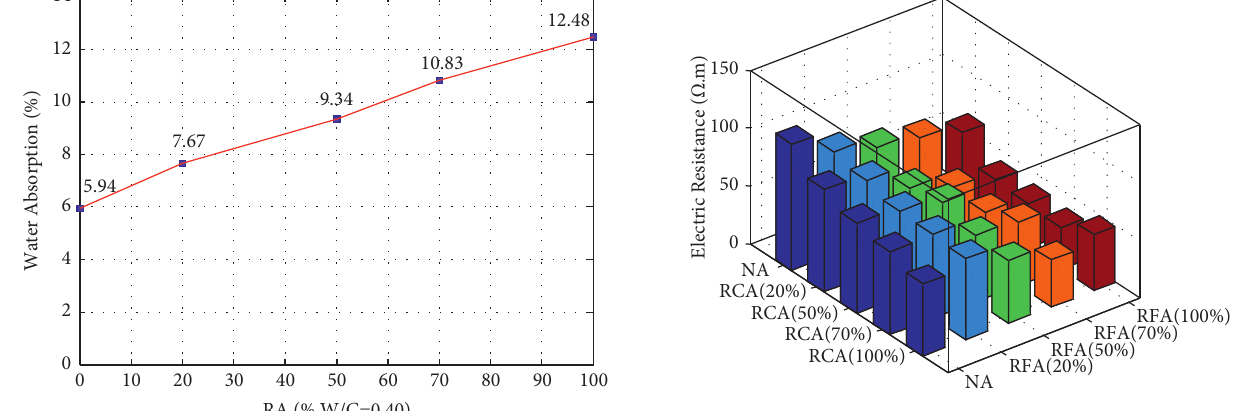
Figure 10: Electric resistance RCA-RFA relationship.